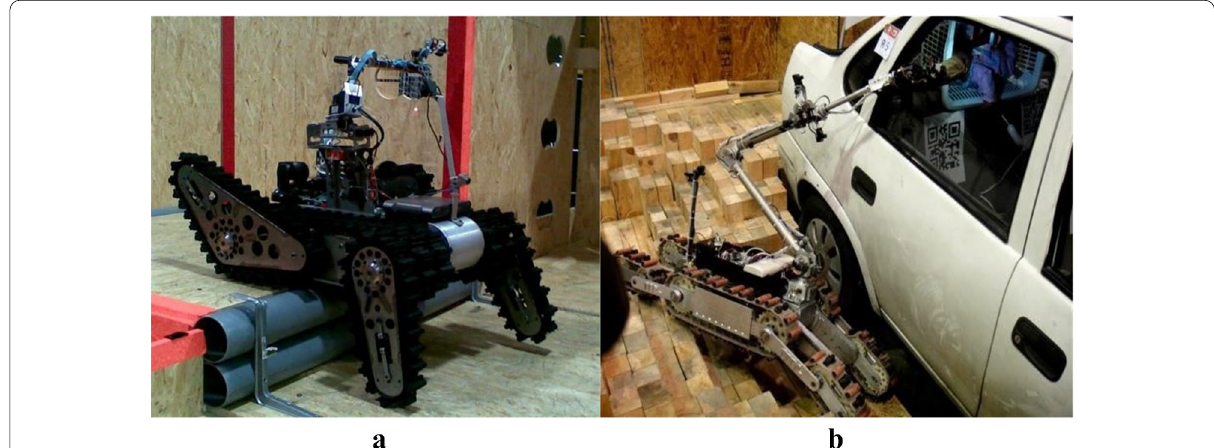
Fig. 2 Two more ancestors of Karo: a illustrates NAJI-VII while overcoming a pipe step in RoboCup competitions 2009, Austria, and b explains Scorpion as inspecting inside a car in RoboCup competitions 2012,